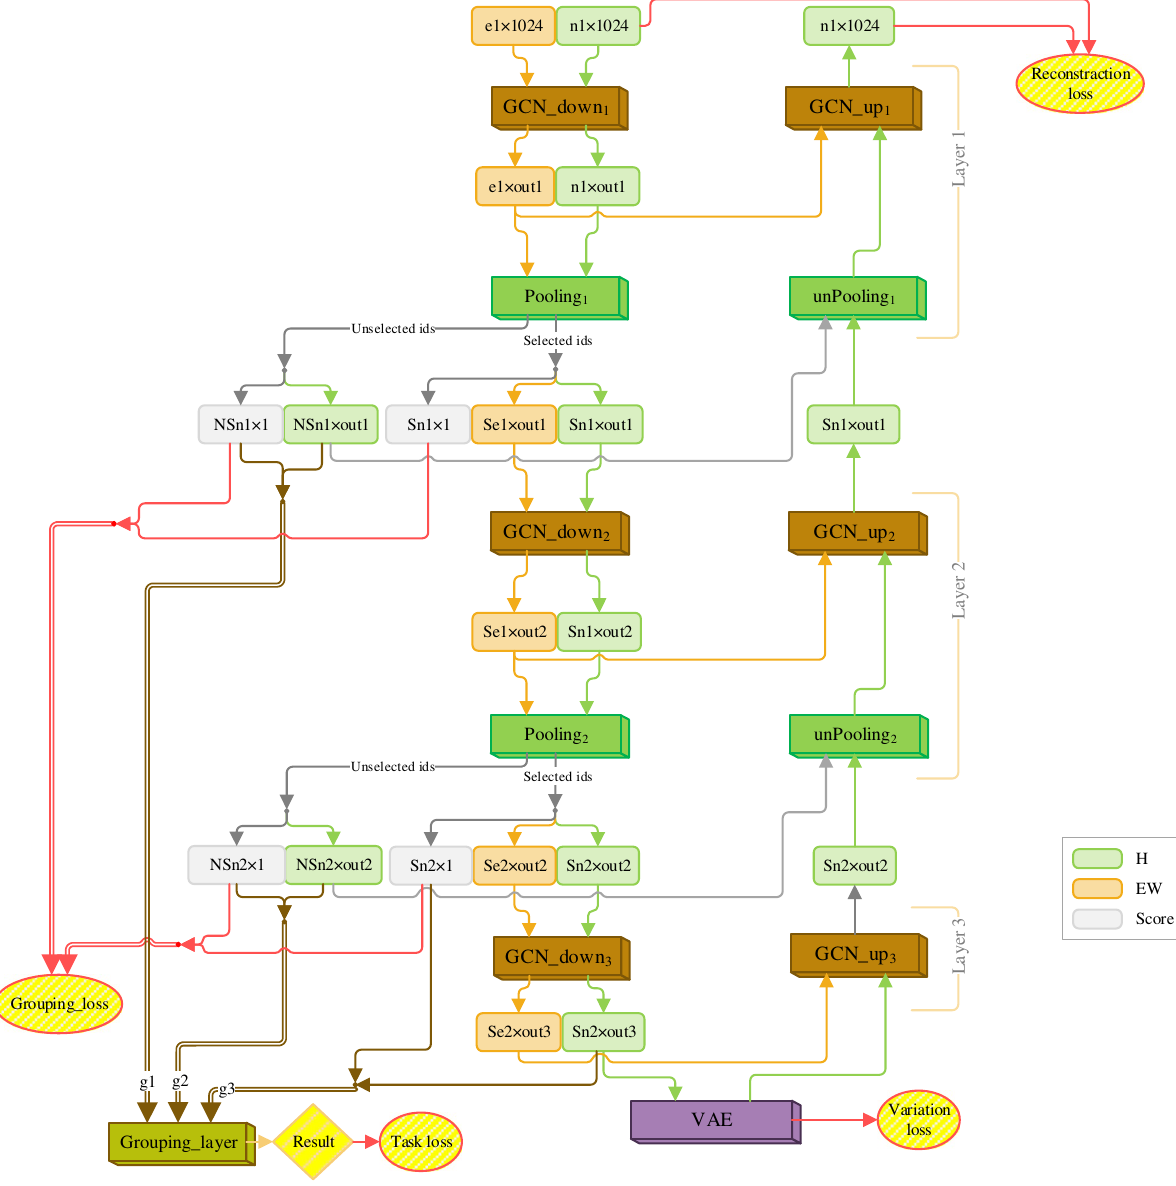
Figure 7. An illustration of our proposed DGNN’s architecture in 3